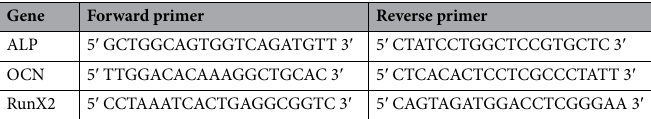
Table 4. Description of the primers used for the gene expression